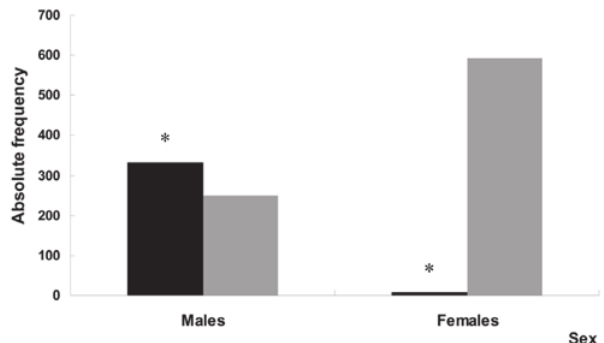
Fig. 2. Occurrence of dorsolateral spots according to sex in Hippocampus reidi . Specimens presenting dorsolateral spots (black bars); specimens without dorsolateral spots (grey bars). (*) Significant difference (p <